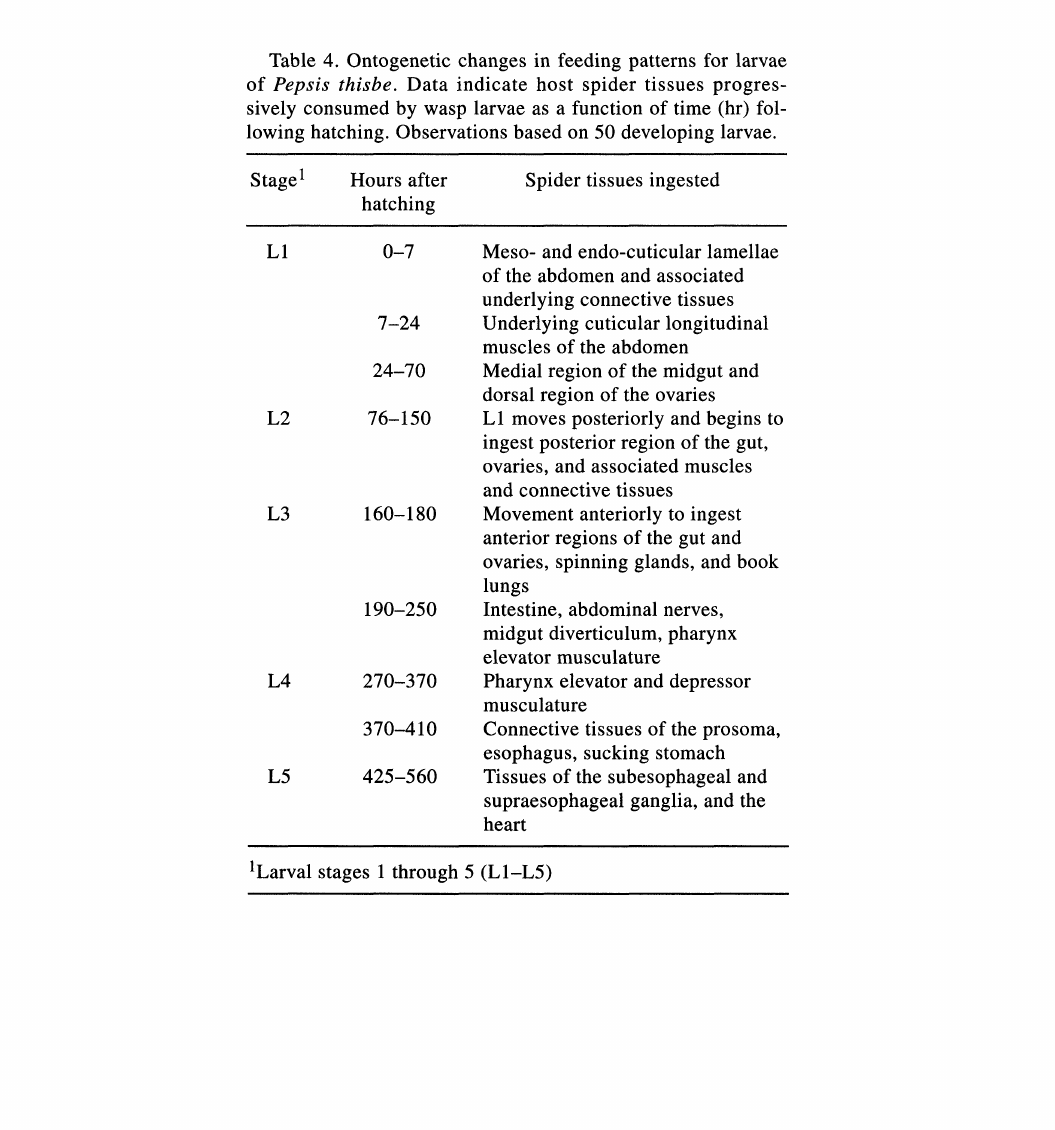
Table 4. Ontogenetic changes in feeding patterns for larvae of Pepsis thisbe. Data indicate host spider tissues